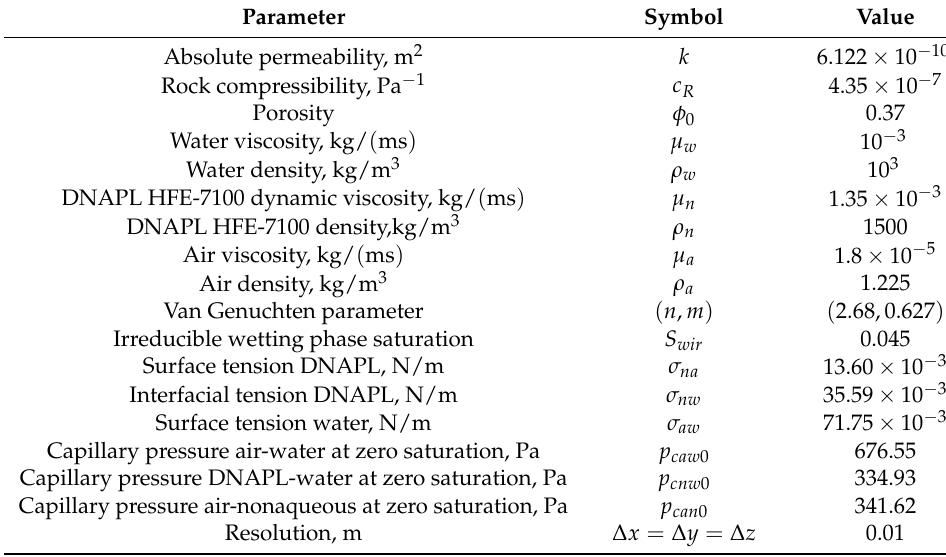
Figure 3. The grid geometry used in the numerical simulation of an immiscible DNAPL inside a saturated column and a grid dimension of 0.060 m × 0.060 × 0.360 m, at the initial time t = 0 s. The red box is the immiscible DNAPL at the top of the parallelepiped in the z − x plane (left-hand side) and the z − y plane (right-hand side), respectively. Table 1. List of parameters used for the three-dimensional numerical simulations of a DNAPL leak in a column.